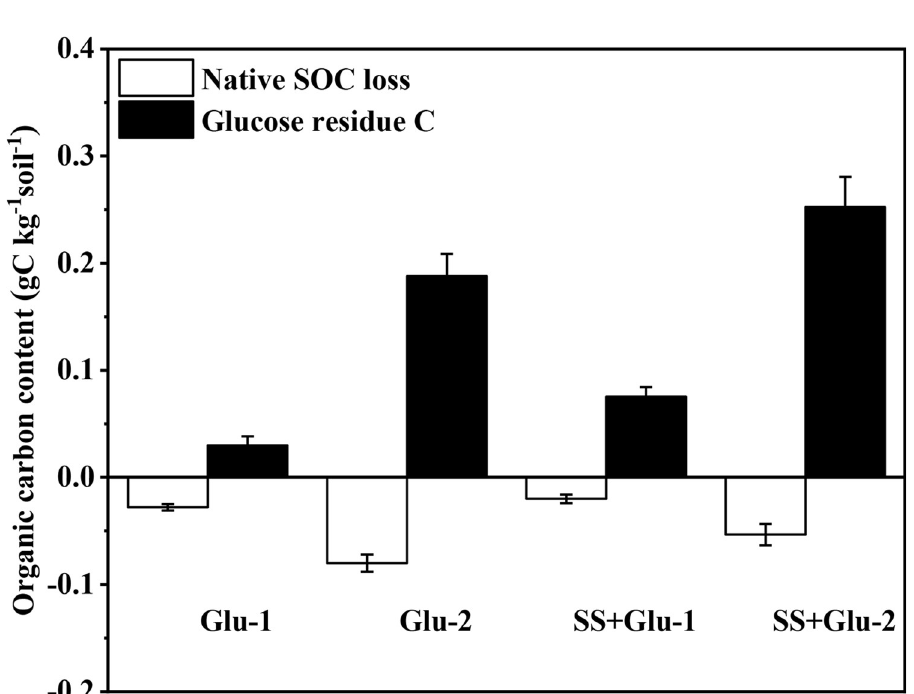
Fig 2. Change in net soil organic carbon balance in the sterilized and non-sterilized soils with glucose addition at day 45. CK, non-sterilized soil without glucose addition; Glu-1, non-sterilized soil with low level of glucose addition; Glu-2, non-sterilized soil with high level of glucose addition; SS, sterilized soil without glucose addition; SS+Glu-1, sterilized soil with low level of glucose; SS+Glu-2, sterilized soil sterilization with high level of glucose addition.